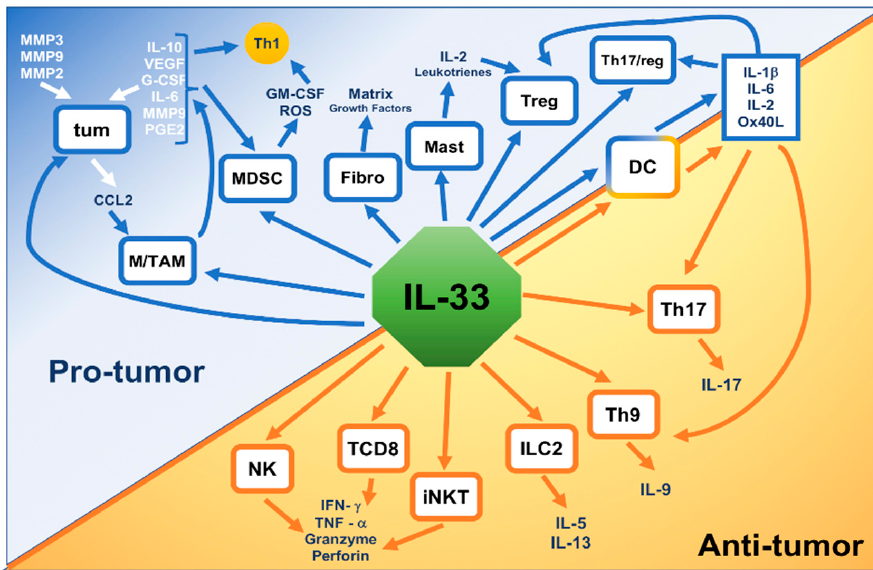
Figure 3. Dual role of IL-33 in cancer.IL-33 released in the TME is able to stimulate cancer cells (tum), fibroblasts (Fibro), and di ff erent immune cells (Macrophages, TAM, MDSC, mast cells, Treg, Dendritic Cells, Th 17, Th 9, Group 2 Innate lymphoid cells (ILC2), invariant Natural Killer cells (iNKT), CD8 + T cells, and Natural Killer cells) which are activated to produce molecules involved in protumor or antitumor processes leading to the development or to the regression of the tumor. Some cytokines produced by protumor cells such as myeloid-derived suppressor cells (MDSC) or Tumor-associated macrophages (TAM), are also able to produce cytokines which inhibit antitumor cells such as all the Th1 cells.